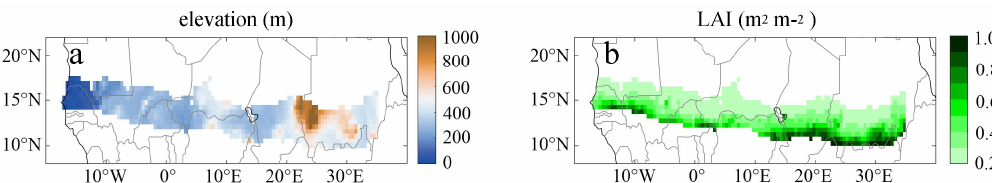
Figure 1. The spatial extension of the Sahel. ( a ) Topography. The DEM (Digital Elevation Model) of GTOPO30 data is used; ( b ) annual averaged leaf area index (LAI) based on Global Inventory Modeling and Mapping Studies (GIMMS) LAI3g dataset between 1982 and 2016.